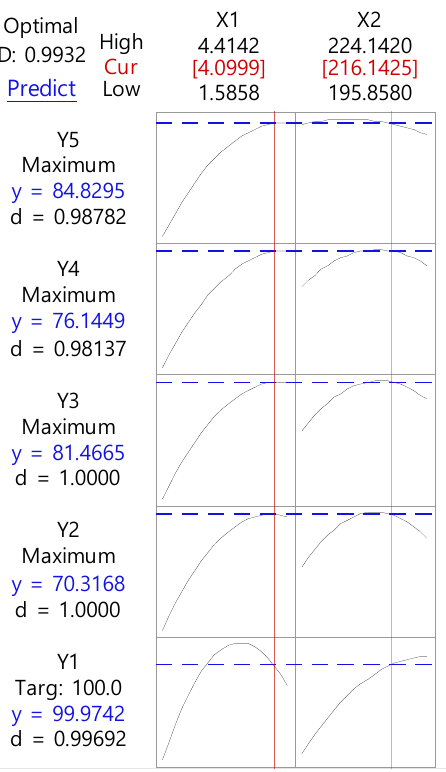
Figure 5. Response optimization profile of dependent variables for independent variables of hot-melt extruded RXB-ASD.